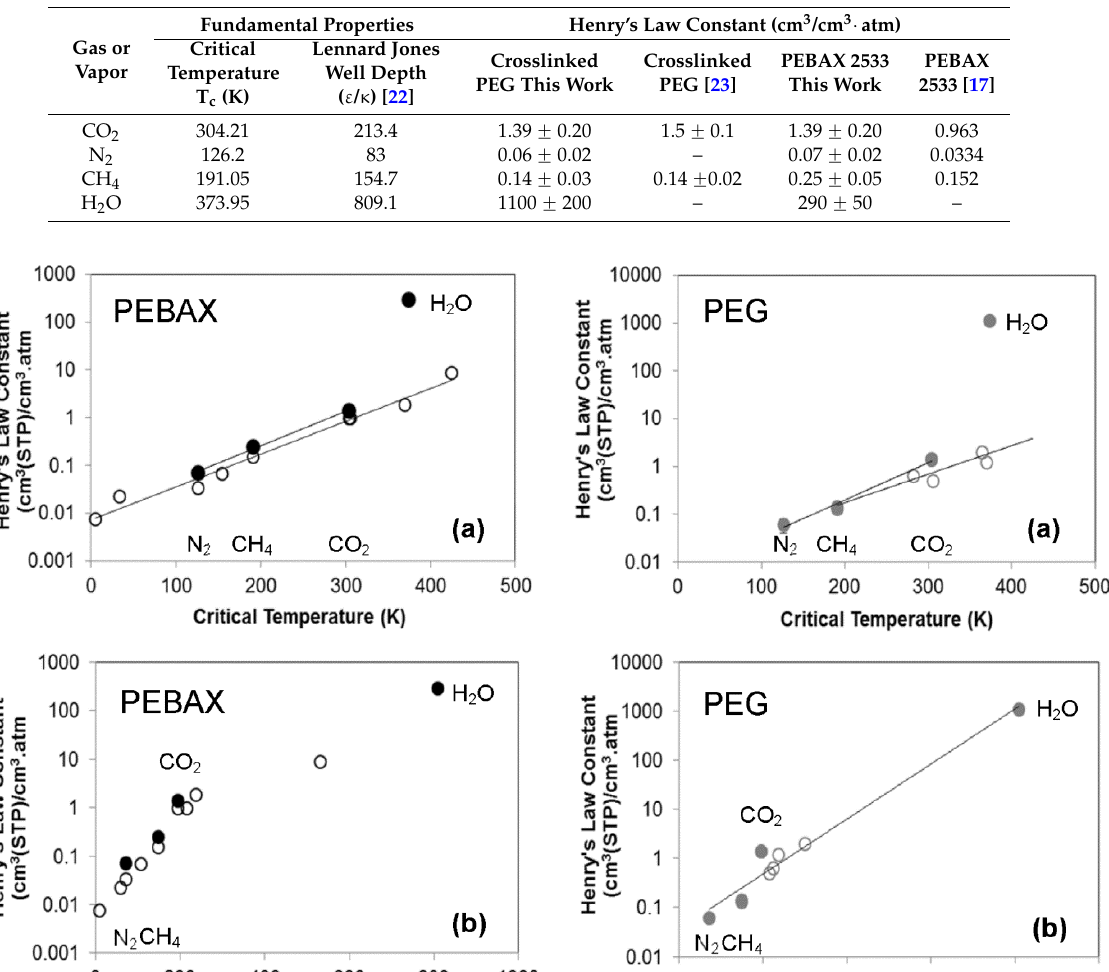
Table 1. Henry’s law constants for pure gases in crosslinked PEG and PEBAX 2533 at 35 ˝ C.